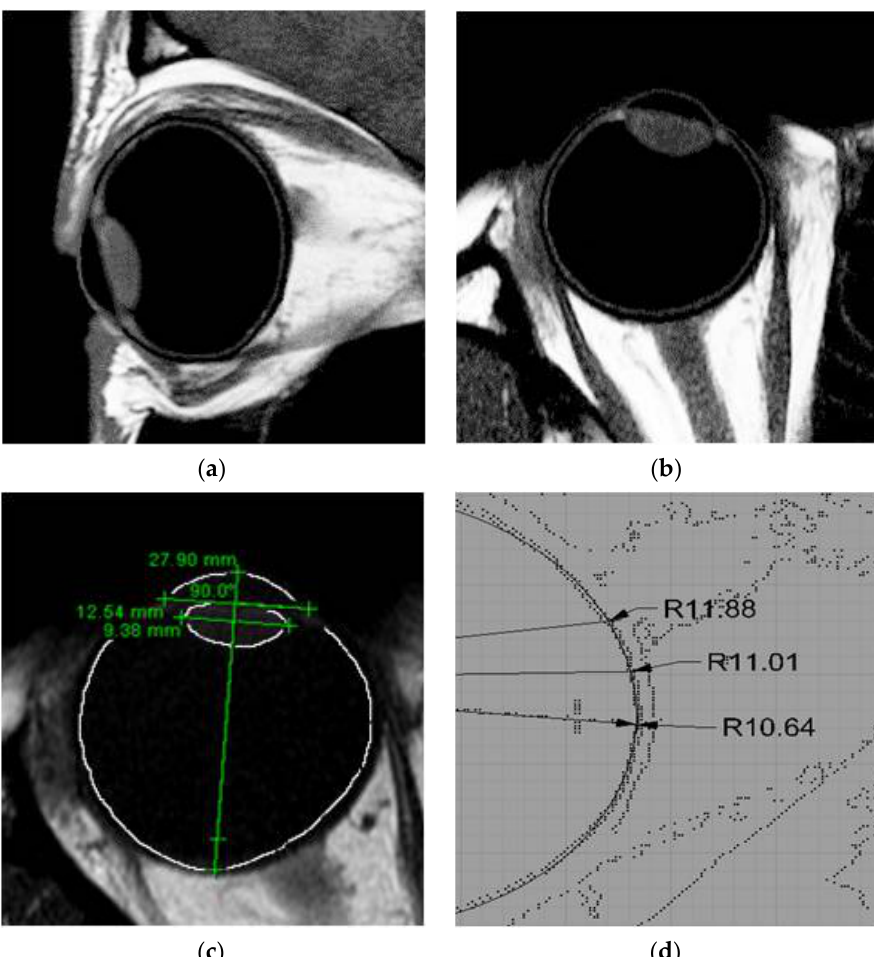
Figure 1. ( a ) Tangential axial MR image of one of the subjects. ( b ) Sagittal axial MR image of one of the subjects. ( c ) Various biometric parameters were measured using magnetic resonance imaging. ( d ) The curvature of the retina was calculated using the Rhinoceros.